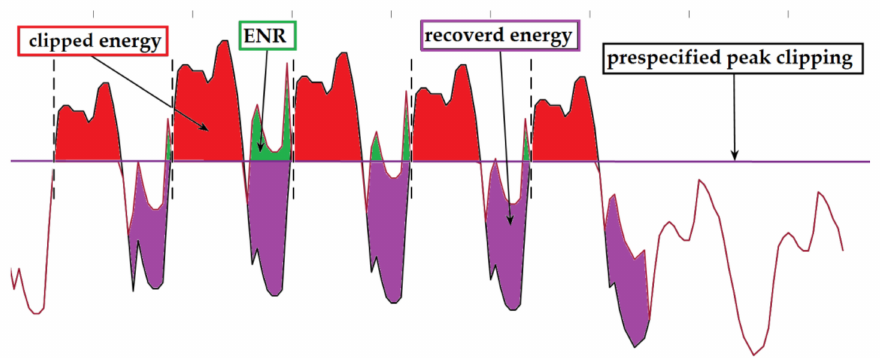
Figure 6. ENR due to peak-clipping actions for PLS.